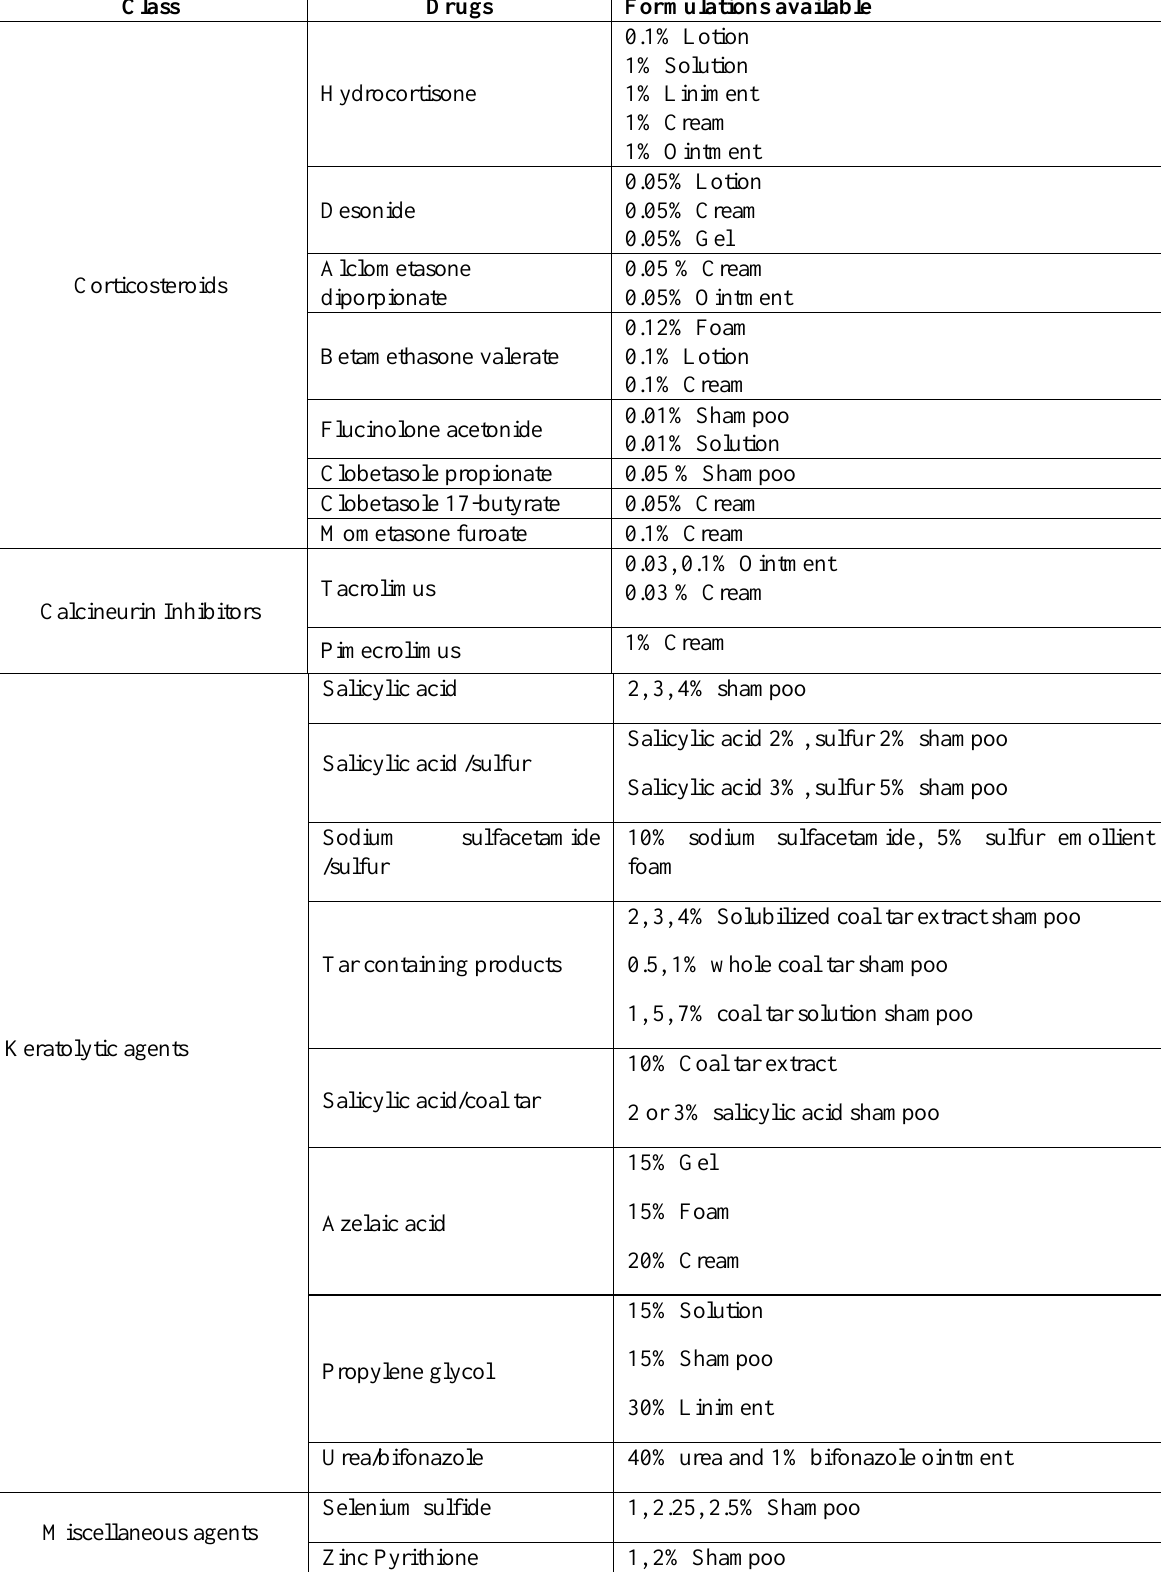
Continue table 1. Topical therapeutic agents used clinically for treatment of dandruff/SD